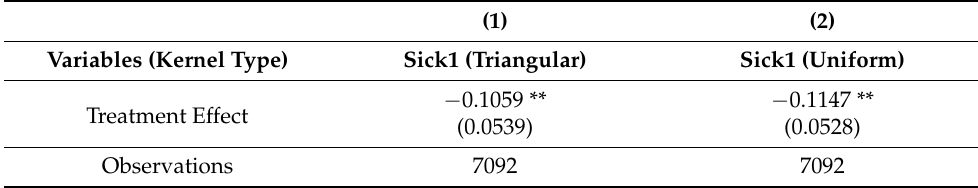
Table 2. Upstream–downstream health gap.